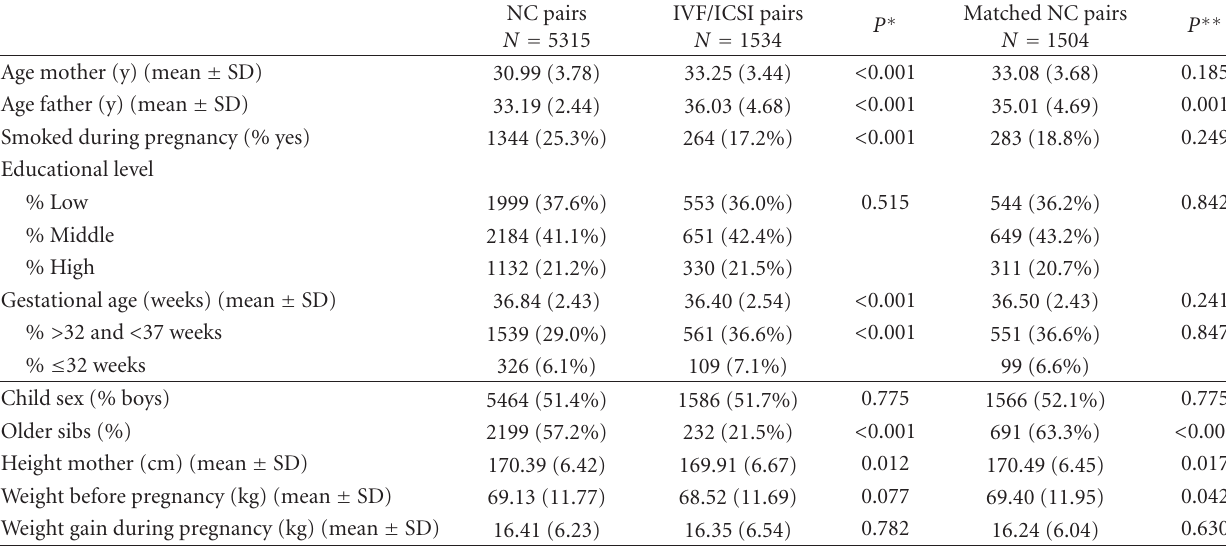
Table 1: Parental, birth, and child characteristics of IVF/ICSI DZ twin pairs, naturally conceived (NC) DZ twin pairs, and a group of DZ twin pairs matched for birth cohort, educational level, maternal age, gestational age, and smoking behavior during pregnancy (matched NC